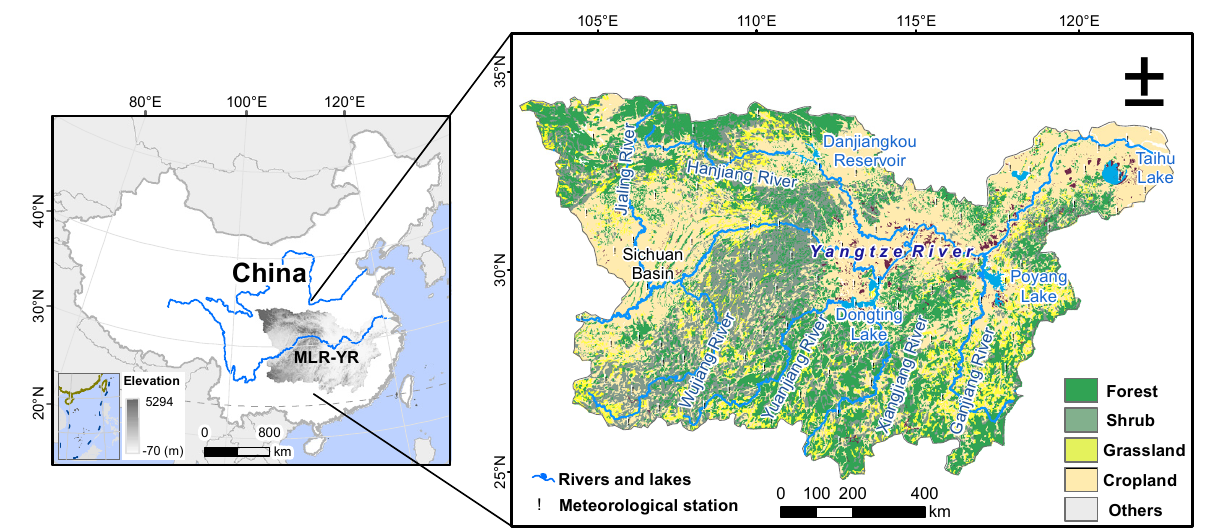
Figure 1. The location of the middle and lower reaches of the Yangtze River (MLR-YR).